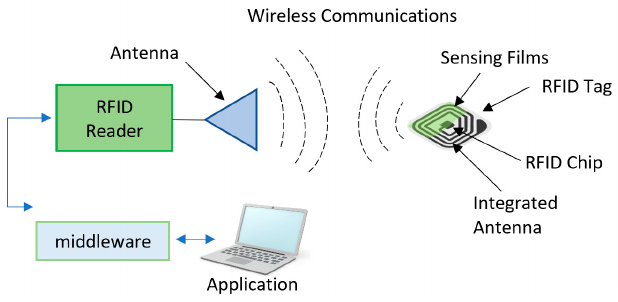
Figure 16. Radio frequency identification (RFID) technology.